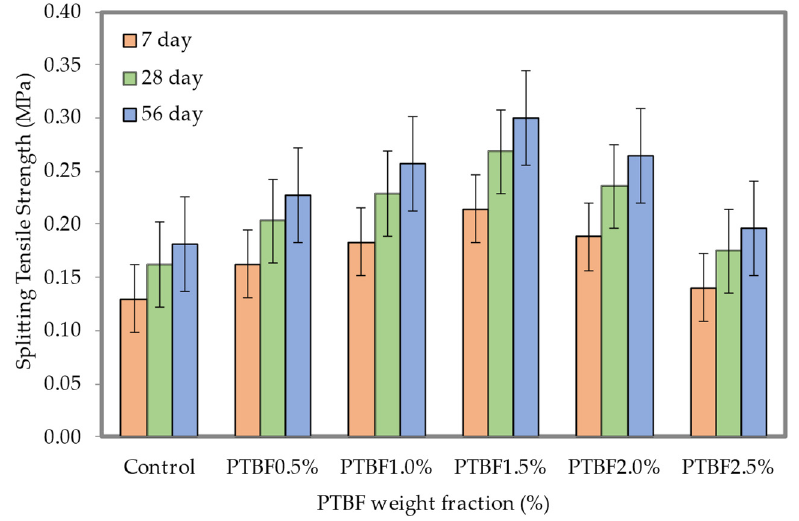
Figure 18. Tensile strength of 500 kg/m 3 density LFC with different weight fractions of PTBF.